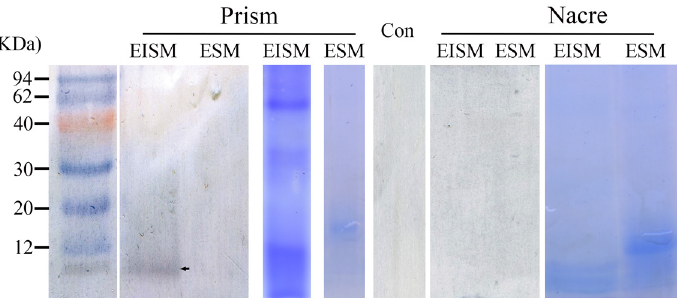
Fig 2. Western blot analyses using anti-rKRMP-3 antibody. The EDTA extracts from the insoluble matrices (EISM) and soluble matrices (ESM) of the prismatic layer, the EISM and ESM of the nacreous layer were applied to SDS-PAGE and subjected to western blot analysis by using anti-rKRMP-3 antibody or preimmune serum as a control. The arrow indicated that KRMP3 existed in the EISM of the prismatic layer. The con lane is the control group incubated with preimmune